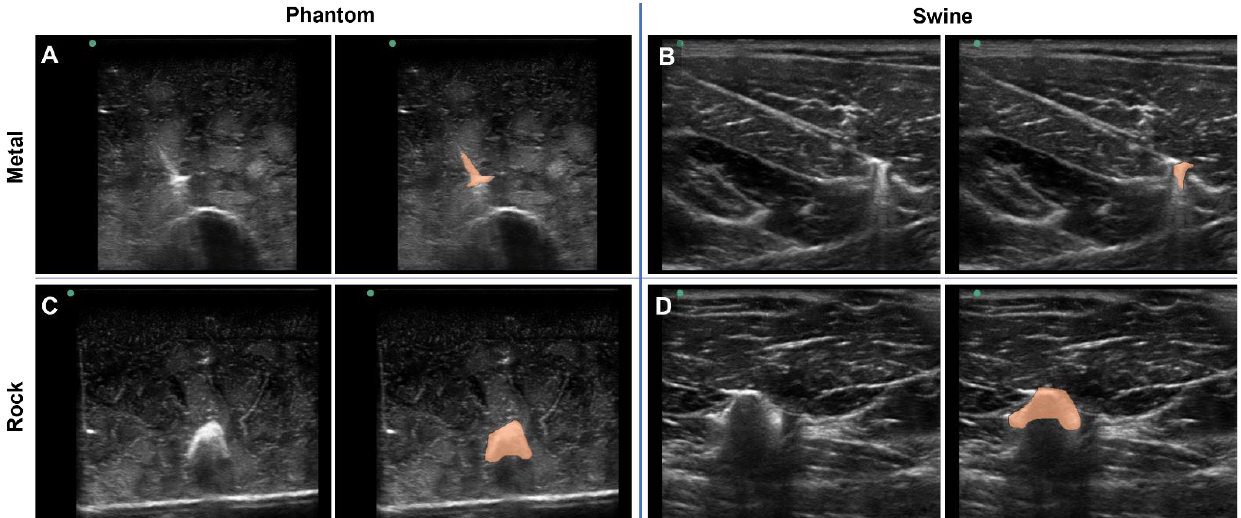
Figure 5 . Shrapnel Embedded in Phantom. Representative ultrasound images for metal shrapnel in phantom ( A ) and swine ( B ), and for rock shrapnel in phantom ( C ) and swine ( D ). Right images are replicates of the left image in each panel with segmentation mask overlays (orange) manually drawn to better identify the location and shape of the shrapnel.